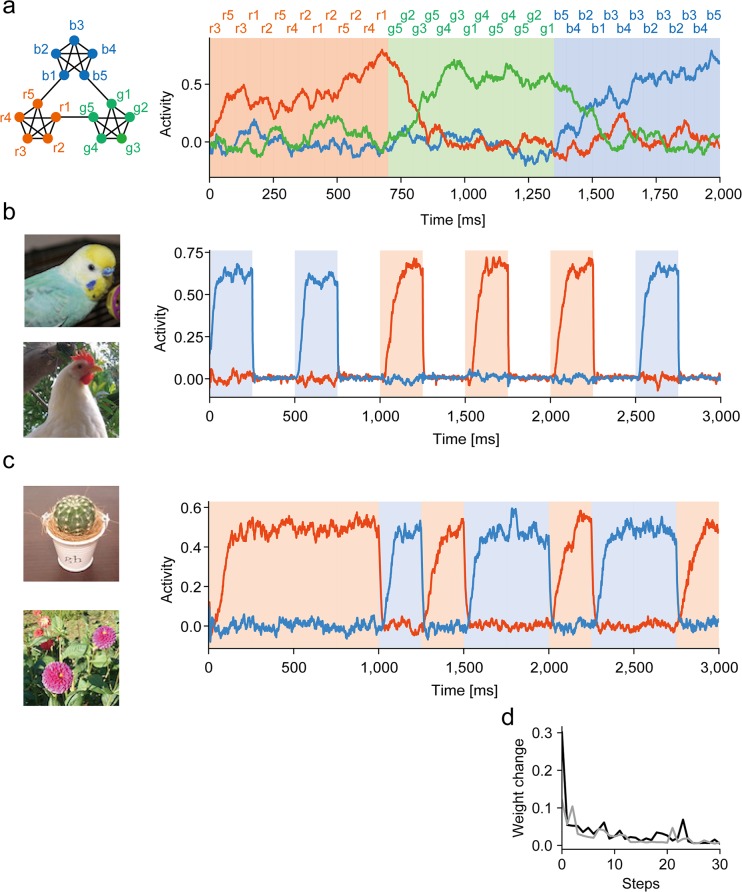
Chunking complex temporal inputs.(a) Sequence inputs were generated by a graph with uniform transition probabilities and community structure. The graph was modified from [23]. (b) Sequence of high -resolution (97x97x3) visual stimuli, where the factor 3 represents the three RGB channels, was chunked. White intervals show periods of Gaussian noise. (c) Sequence of high-resolution (97x97x3) visual stimuli was chunked. (d) Learning curves are compared for the images shown in (c) between high (black) and low (gray) resolution versions. The images were repeatedly presented without noise intervals.